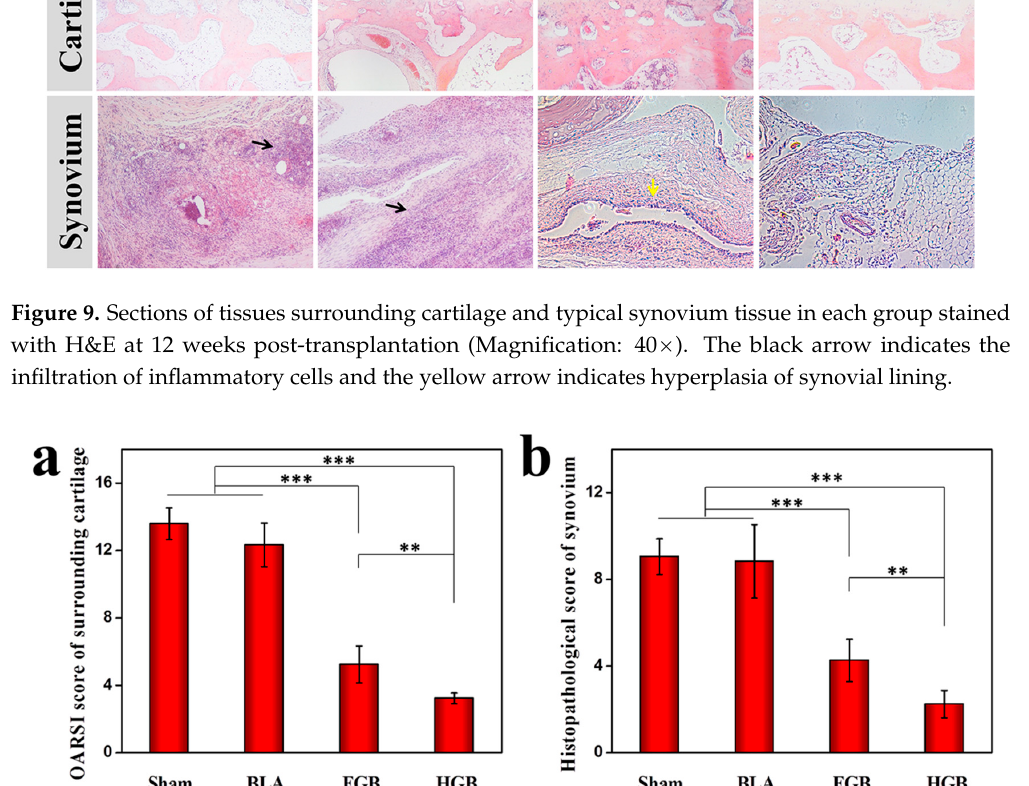
Figure 10. ( a ) Modified OARSI score of sections surrounding cartilage and ( b ) histopathological scores of synovial tissue in each group evaluated 12 weeks after transplantation. The results are representative of means ± SD ( n = 3, ** p < 0.01, *** p < 0.001).